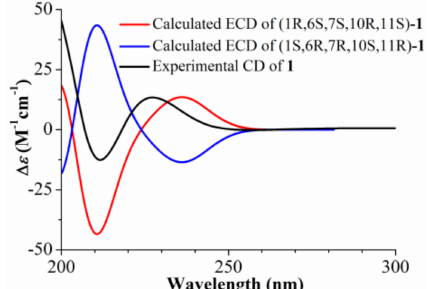
Figure 4. Calculated and experimental ECD spectra of compound 1 .